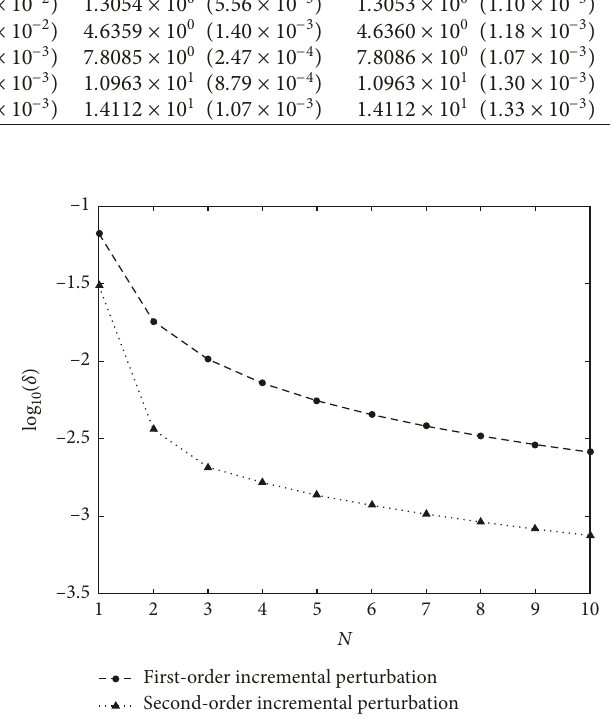
Figure 20: The error parameter, δ , for the perturbed modal ma- trices of the nonuniform rod as a function of N for a � 0 . 55. The natural frequencies are nondimensionalized by dividing by ������� 􏽰 E / ( ρ L 2 ) .